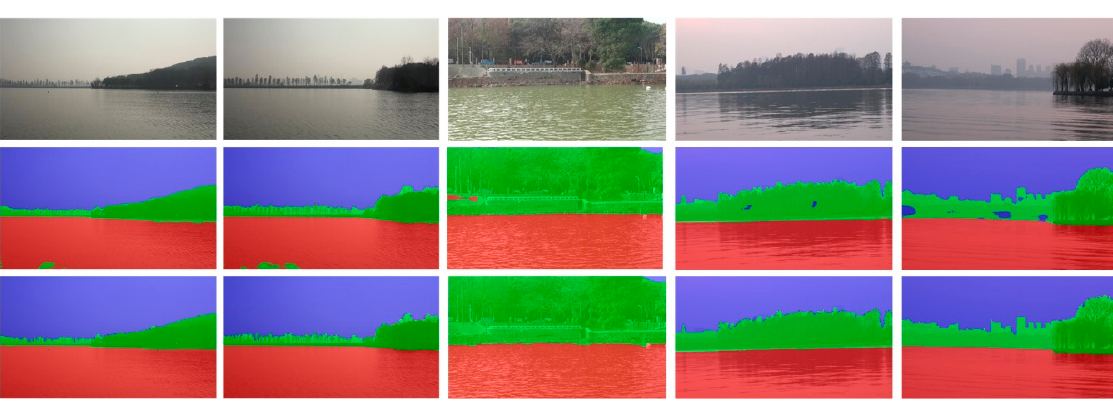
Figure 5. Refinement of the network prediction.